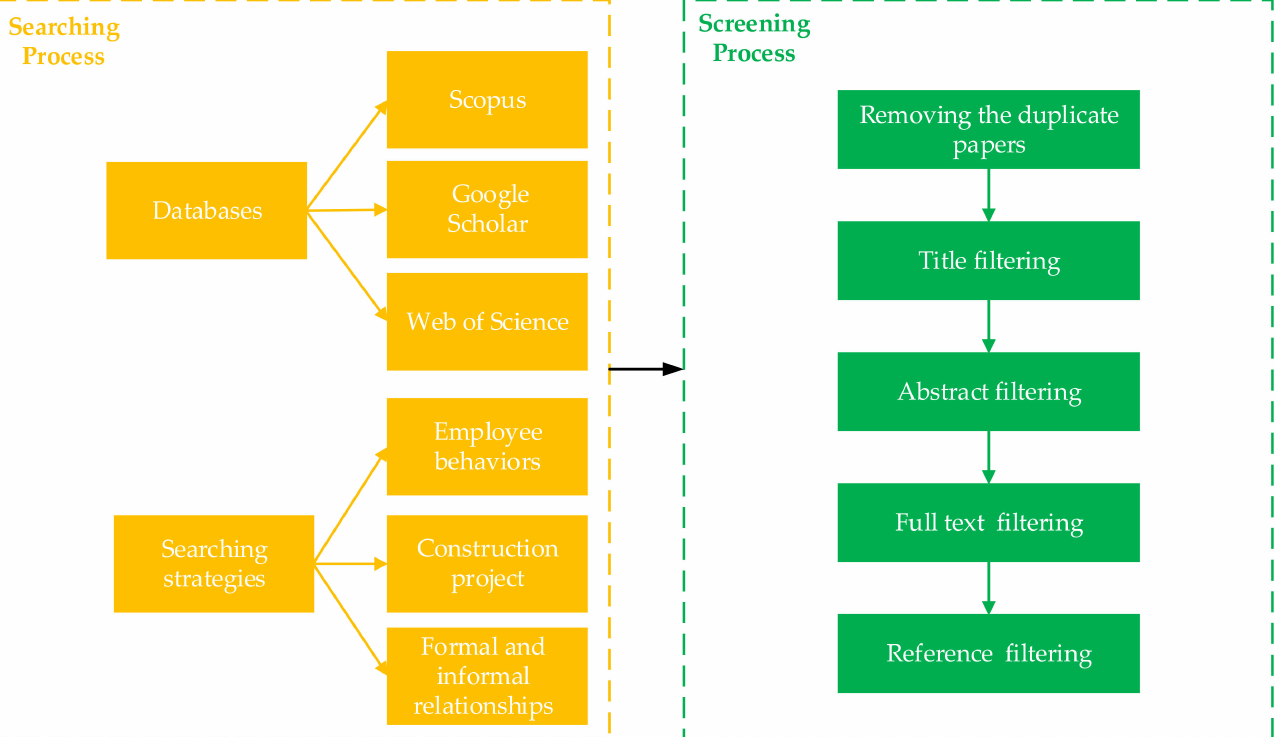
Figure 1. Flowchart of searching and screening process in